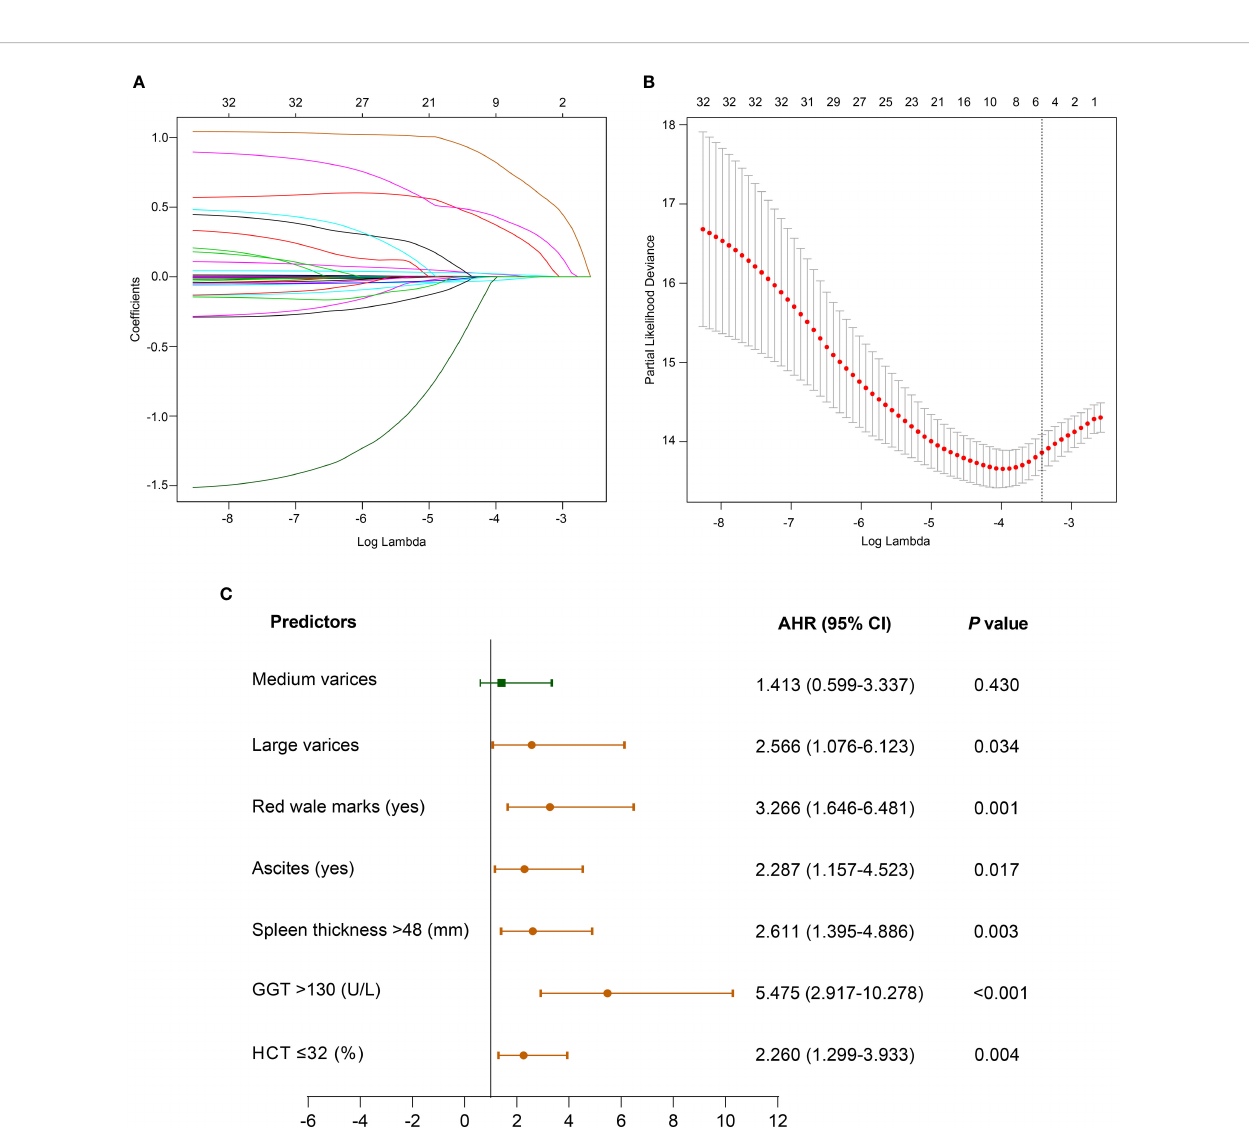
FIGURE 2 Clinical characteristics selection using the LASSO Cox regression model. (A) LASSO coef fi cient pro fi les of the 32 variables. (B) 10-fold cross-validation is applied to select the most suitable parameter using LASSO regression model. The vertical line on the right is plotted with six selected variables, which constructed a more concise model within one standard error. (C) Forest plot of multivariate Cox regression analysis of the selected variables in the derivation cohort. Abbreviations: AHR, adjusted hazard ratio; CI, con fi dence interval; GGT, g -glutamyltransferase; HCT, hematocrit; LASSO, least absolute shrinkage and selection